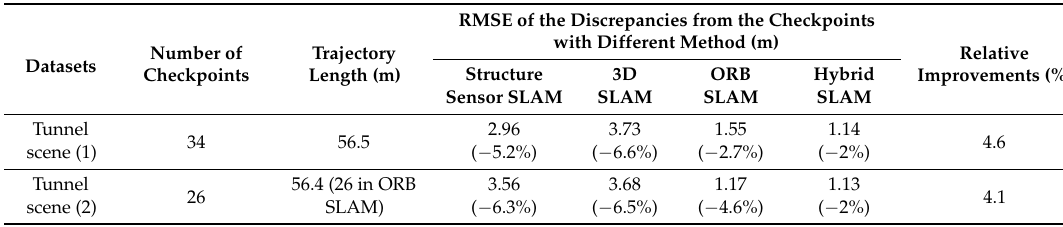
Figure 11. Absolute mapping errors of the checkpoints along with camera trajectories. Table 3. Absolute mapping accuracy of tunnel scenes using different SLAM methods.